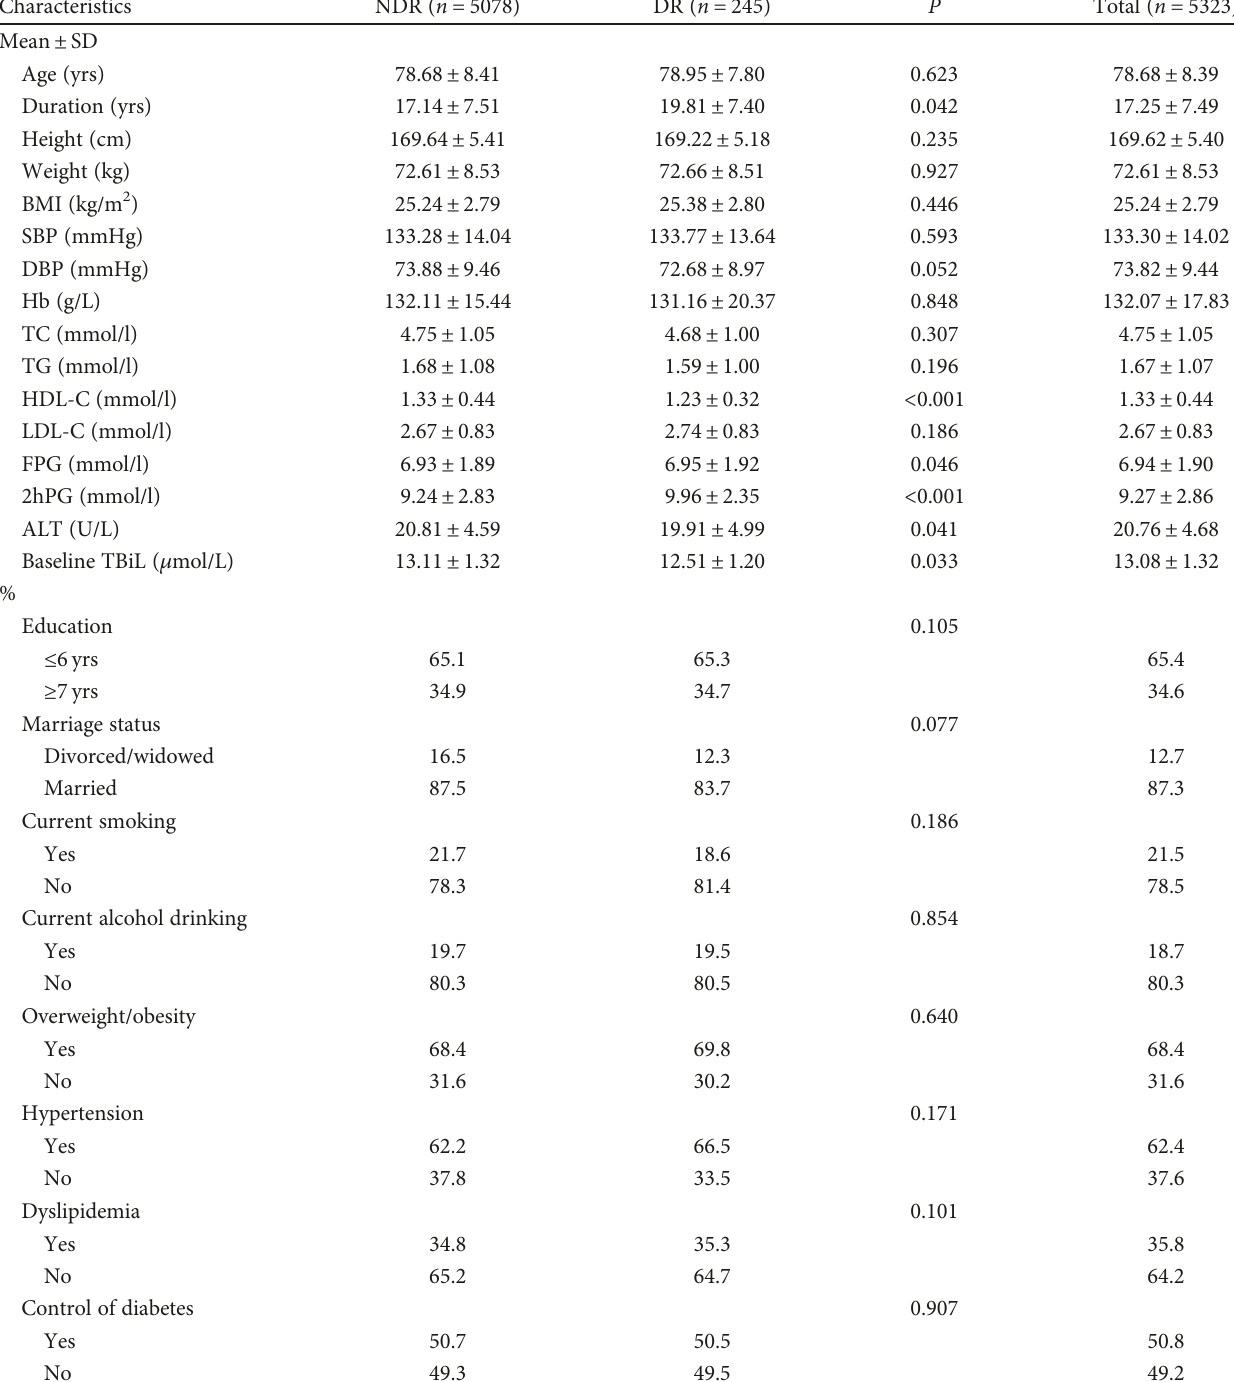
Table 1: General characteristics of participants according to DR